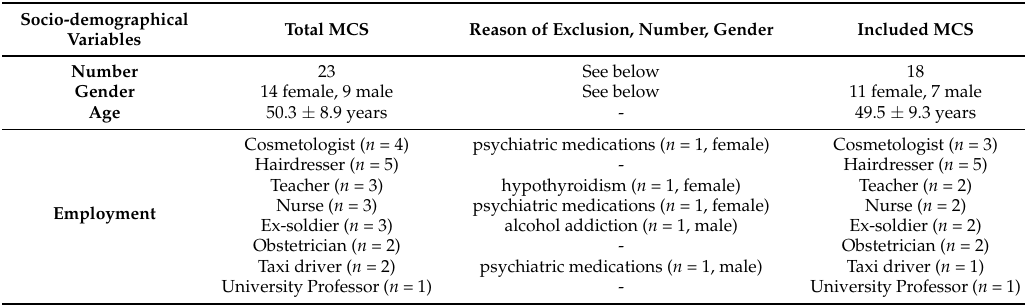
Table 1. Socio-demographic and medical details of total and included MCS patients after clinical work-up. MCS, Multiple Chemical